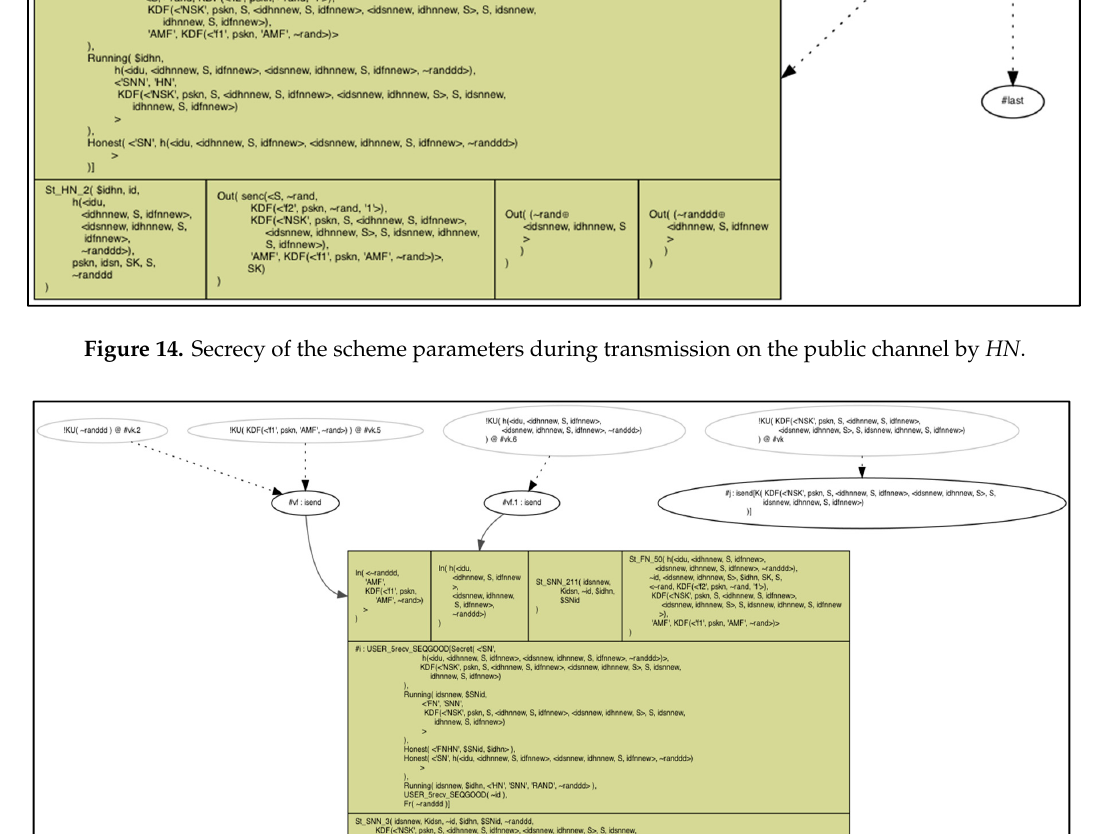
Figure 15. Secrecy of the scheme parameters during reception from the public channel by FN .